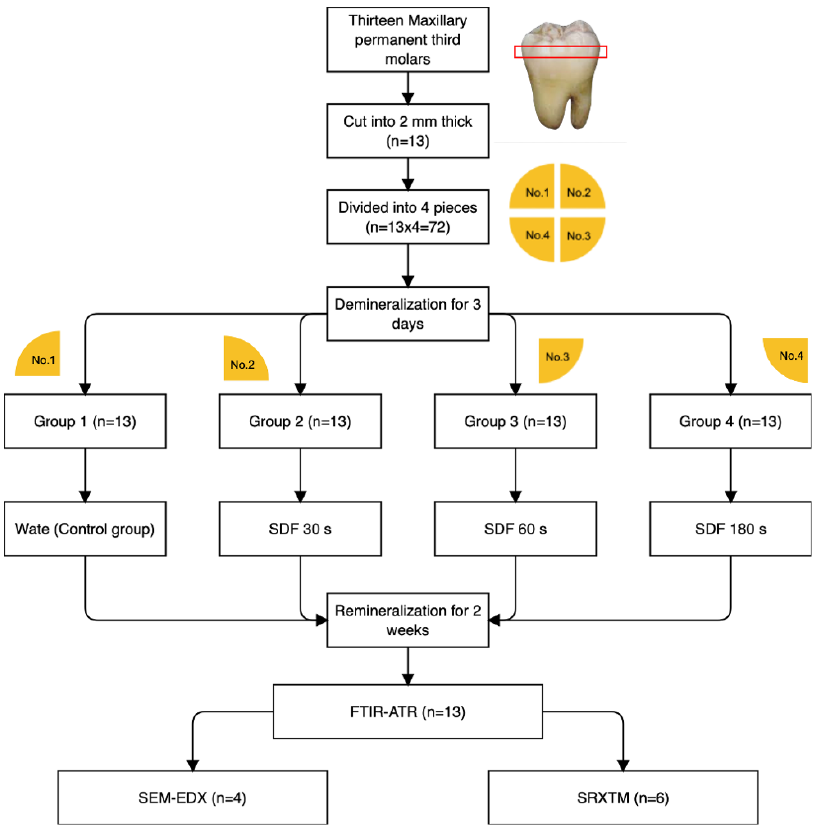
Figure 1. Flowchart representing the methods used in the current study.